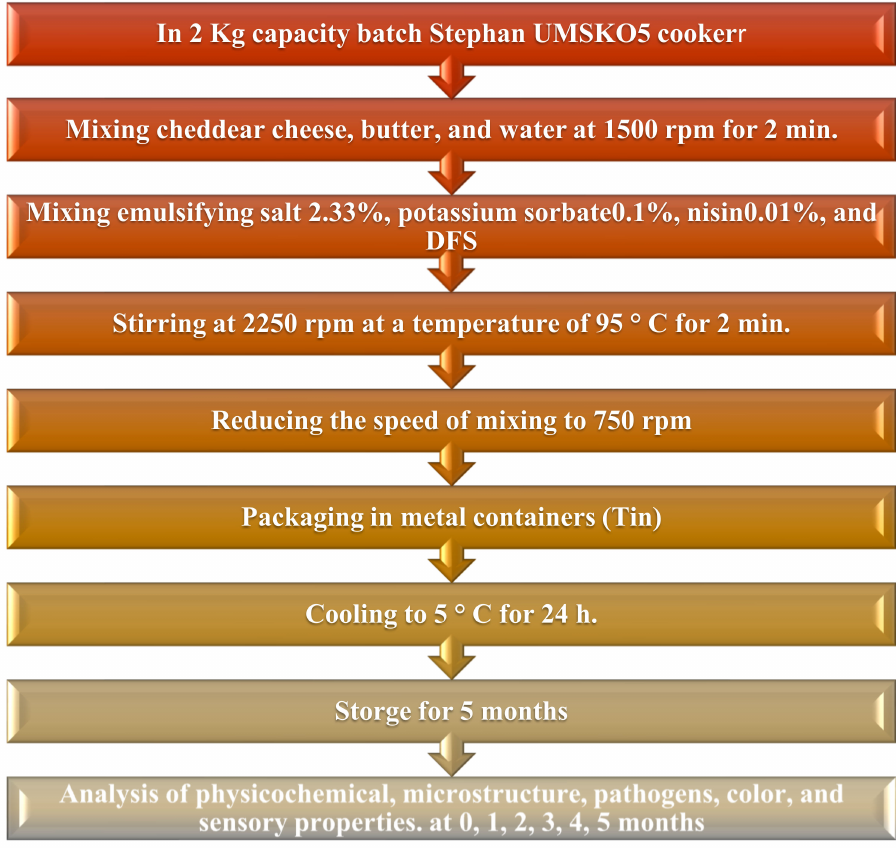
Figure 2. Flowchart of the effect of each ingredient in the manufacturing process of block-type processed cheeses